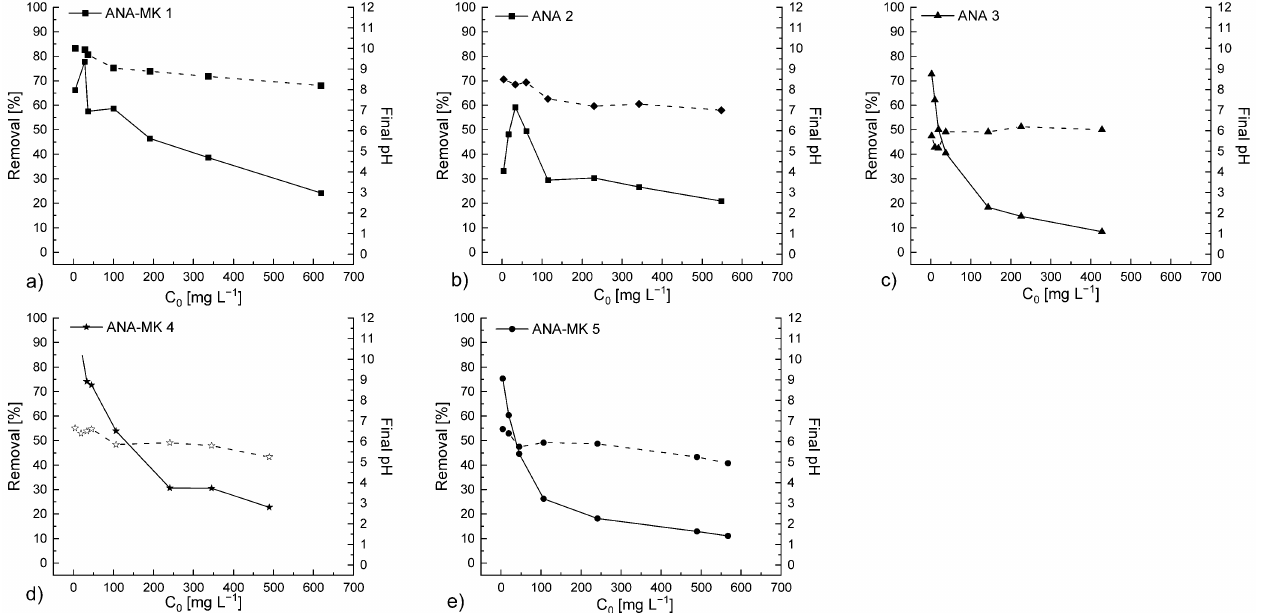
Figure 7. Effect of initial concentration on NH 4+ ion removal onto ( a ) ANA-MK 1, ( b ) ANA 2, ( c ) ANA 3, ( d ) ANA-MK 4, and ( e ) ANA-MK 5. The removal percentage for NH 4+ ions is represented by a solid line, and the final pH values are represented by a dashed line. Experimental conditions: sorbent dosage: 5 g L −1 ; initial pH of the solution: 2.5; contact time: 24 h; and temperature: 22 °C – 23 °C. Analysis was based on the concentrations of NH 4+ -N.